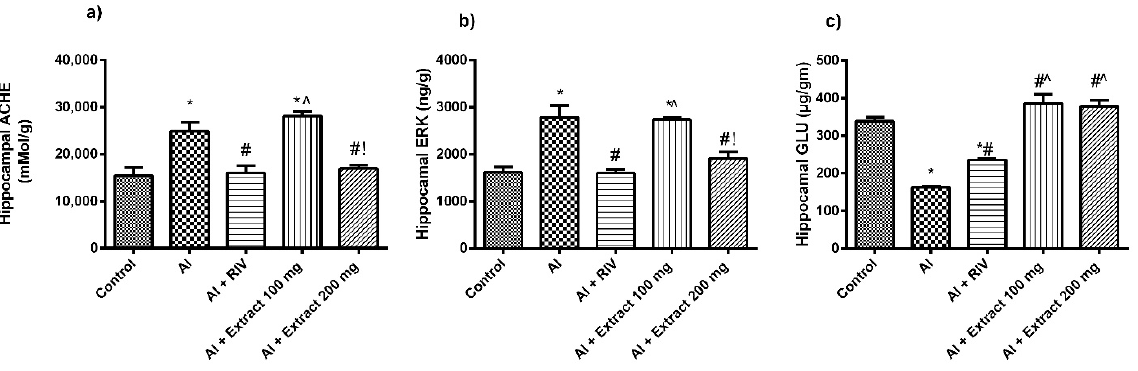
Figure 3. Effect of H. abyssinica extract on ( a ) AChE content and ( b ) ERK level in hippocampus. ( c ) Glutamate level in hippocampus. * Significant difference from control group at p < 0.001, # significance difference from AlCl 3 group at p < 0.001. ˆ Significant difference from RIV group at p < 0.001, ! significant difference from 100 mg group at p < 0.001.